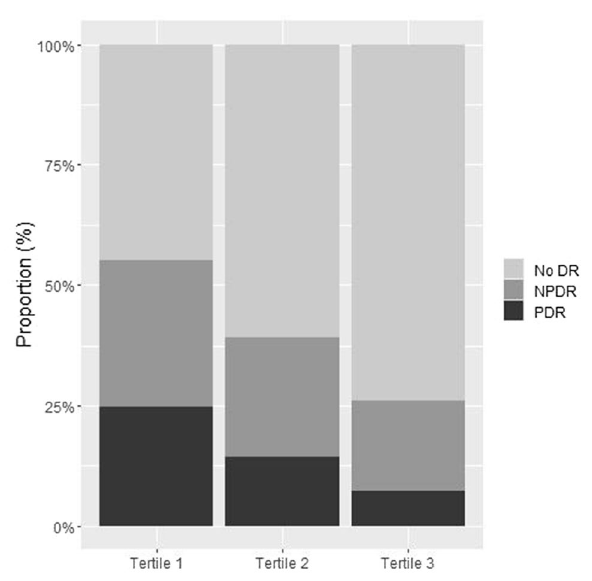
Figure 2. Retinopathy proportion according to GNRI